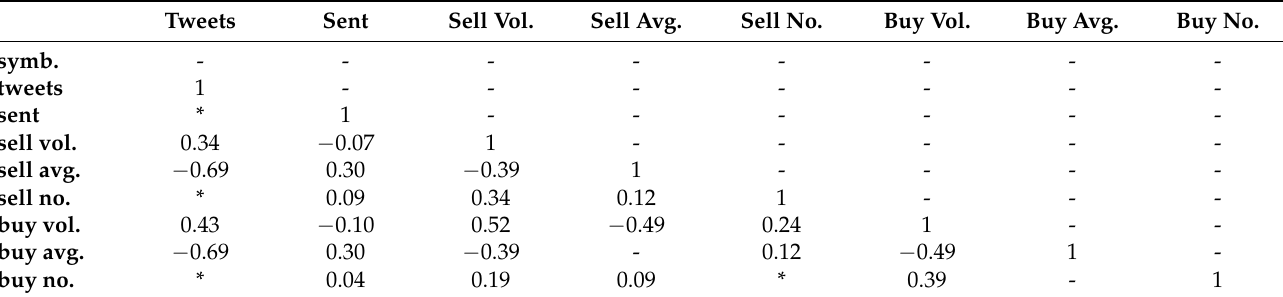
Table 3. Pearson correlation matrix.